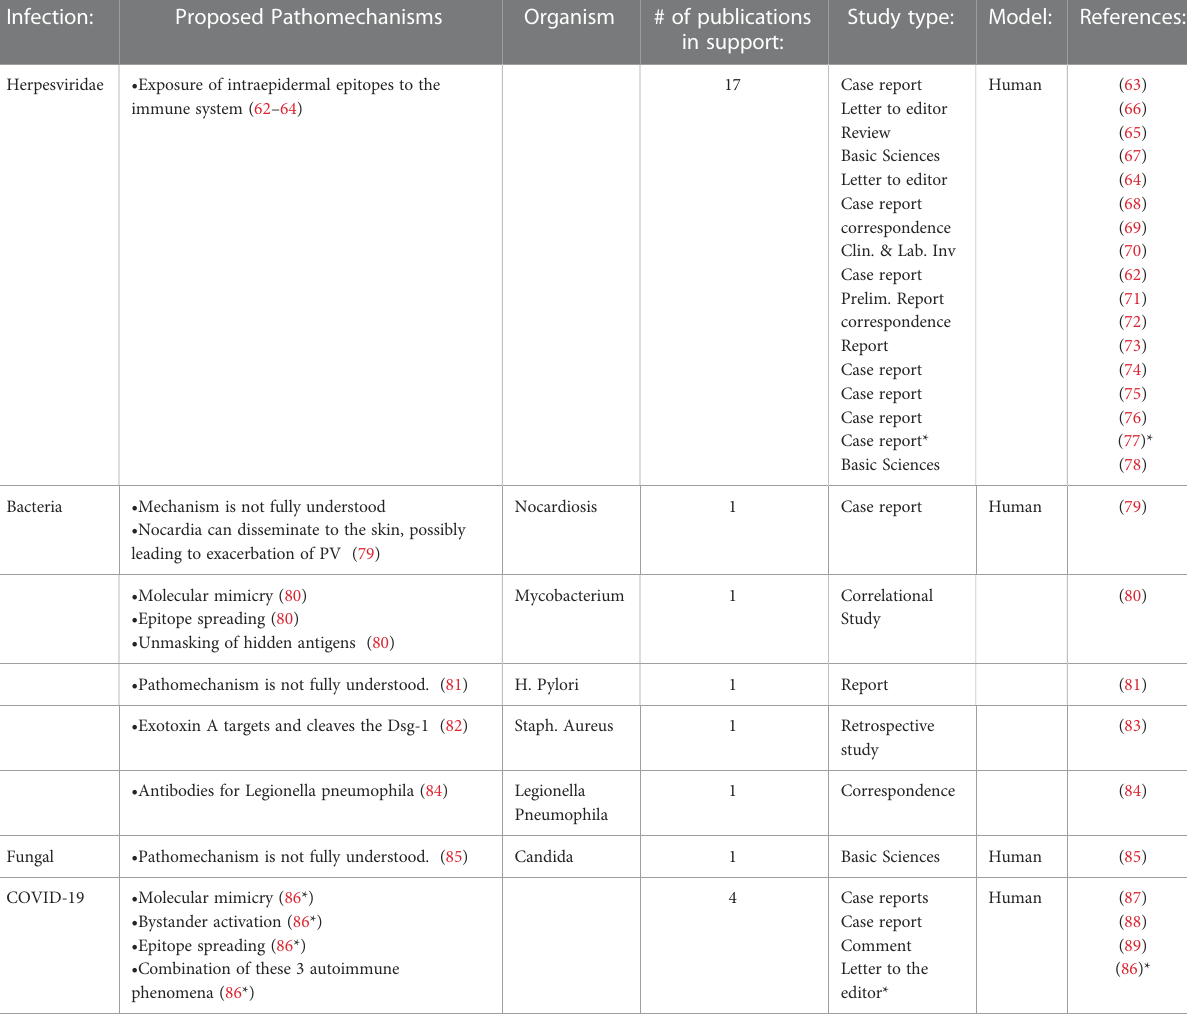
TABLE 3 Studies in support of the hypothesis that PV is triggered or exacerbated by